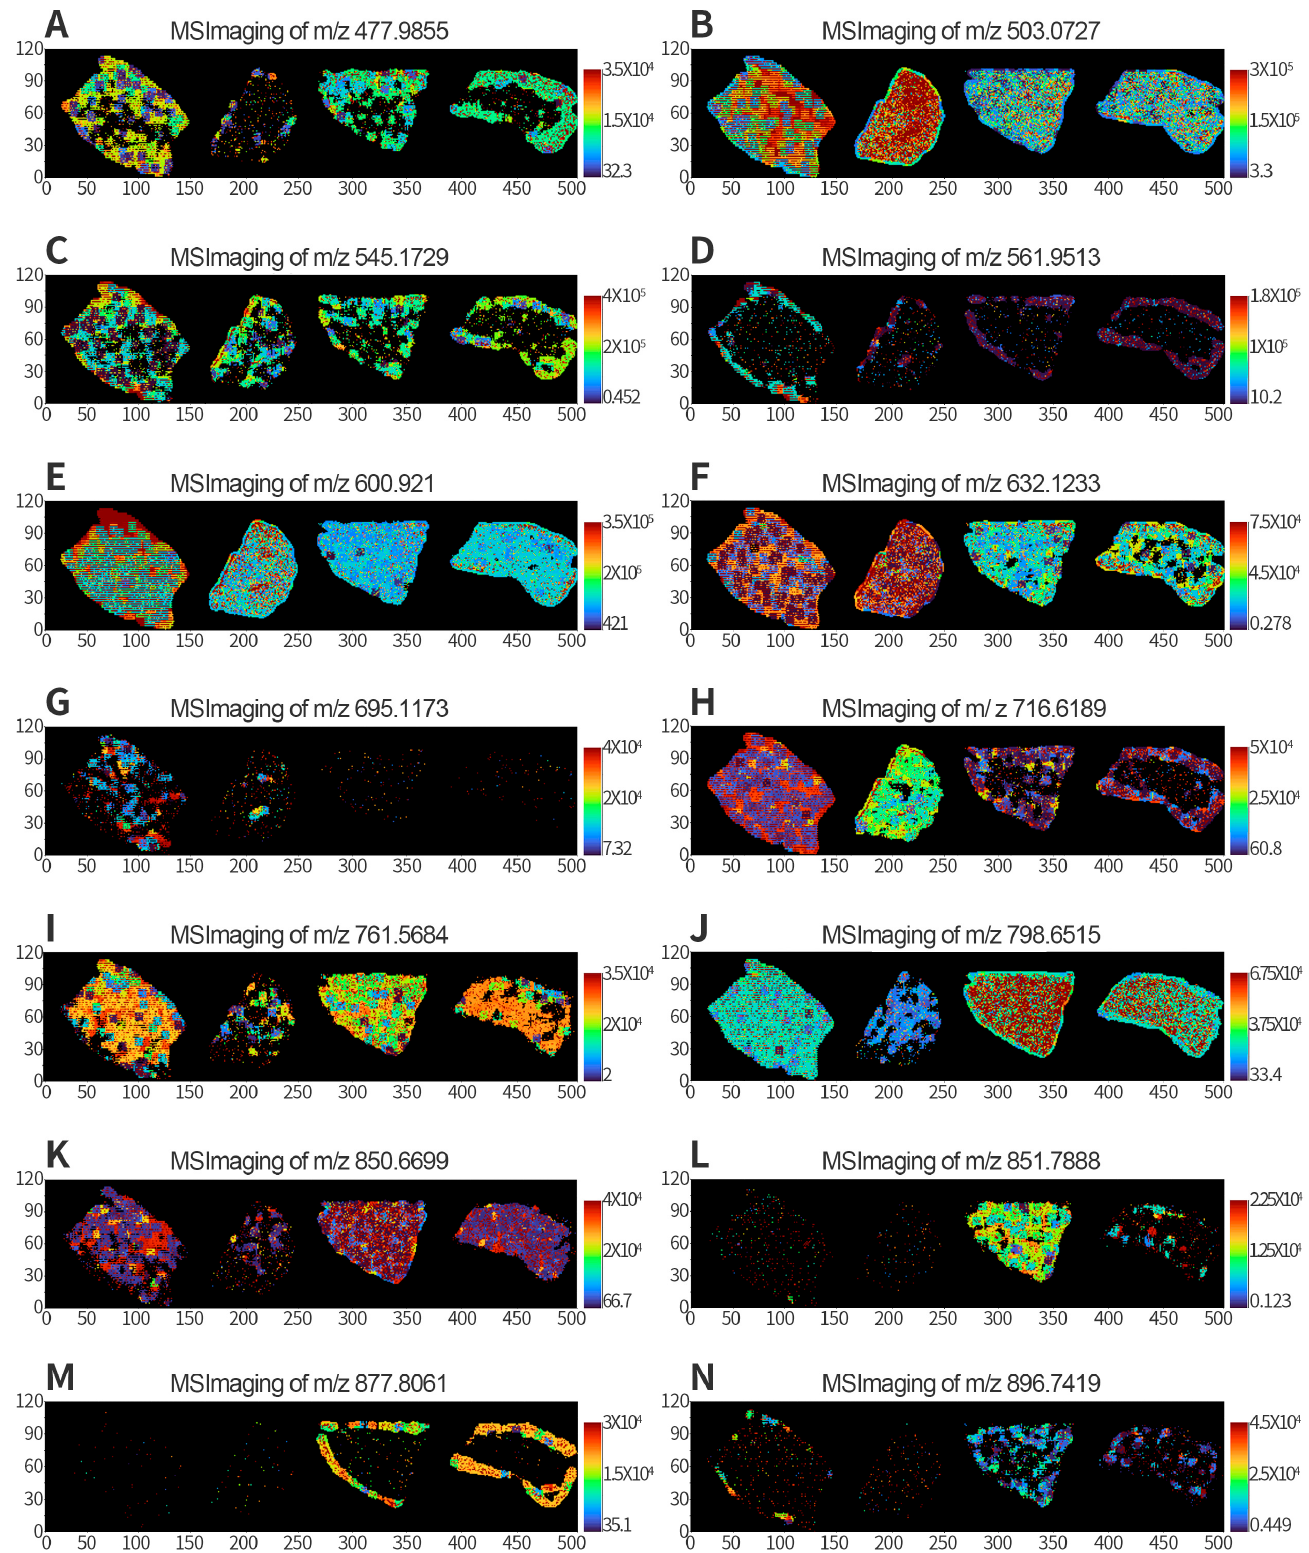
Figure 6. MSI of differential metabolites from different samples in rat liver. ( A – N ) Metabolite intensity images for various m / z of 477.9855, 503.0727, 545.1729, 561.9513, 600.921, 632.1233, 695.1173, 716.6189, 761.5684, 798.6515, 850.6699, 851.7888, 877.8061, and 896.7419, respectively.